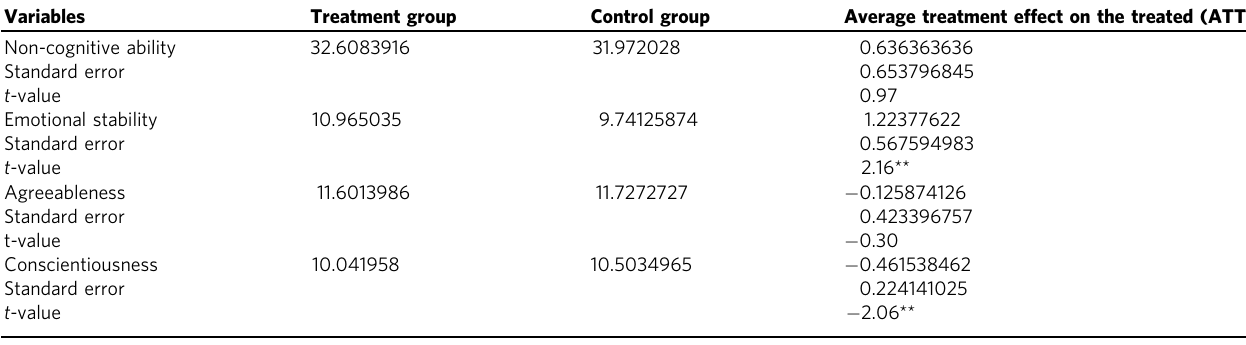
Table 8 The results from the PSM exercise for maternal migrating households.